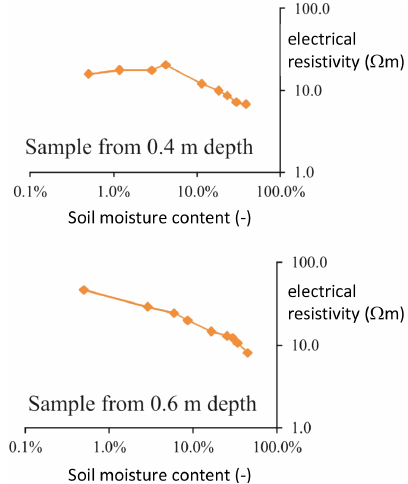
Figure 6. Experimental relationships between resistivity and mois- ture content determined in the lab on samples taken at two different depths at the Bulgherano site, using water having the same electrical conductivity measured in the porewater in